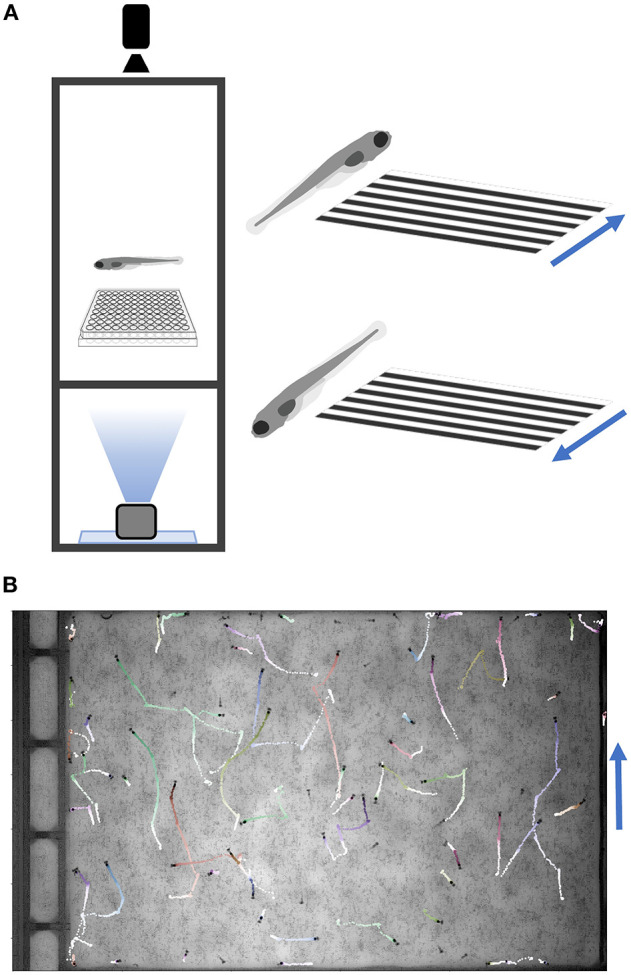
Optomotor Response Assay. (A) Diagram of the optomotor response assay. Larvae are tracked while a moving grating is projected from below. Blue arrows denote grating movement direction. (B) Fish trajectories (light to dark) during a 25-s movie (30 fps). Multiple fish were placed in a plate without well-dividers. Tracking code is available on GitHub (Methods).